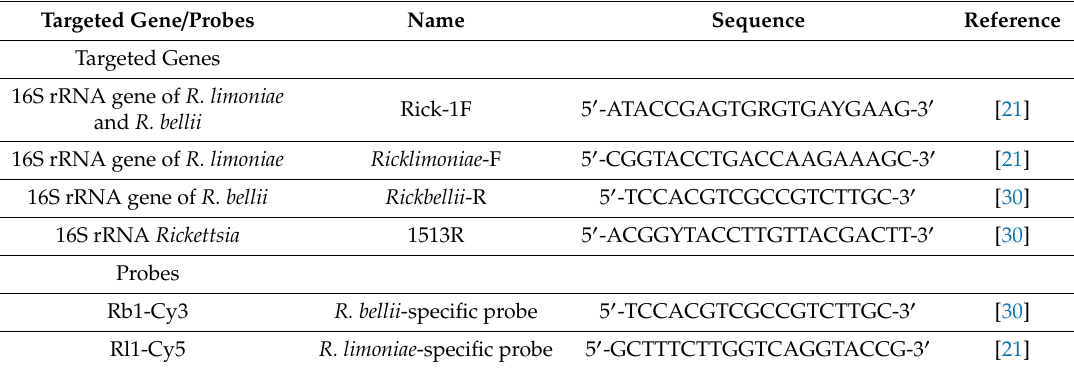
Table 1. Primers and probes used to identify Rickettsia bellii and R. limoniae in M. pygmaeus . Targeted Gene /